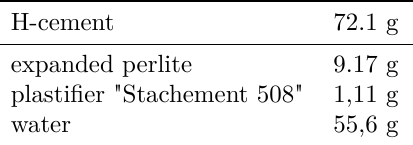
Table 1. Composition of H-cement mortar with ex- panded